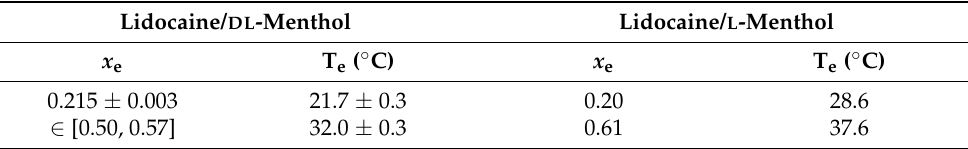
Table 4. Temperature and composition data of the eutectic points for the lidocaine/ DL -menthol phase diagram obtained in the present study and compared with the data of the lidocaine/ L -menthol phase diagram reported in reference [44]. The eutectic points for the lidocaine/ DL -menthol system were determined with the Tammann plots described in reference [64] ( cf. Figure